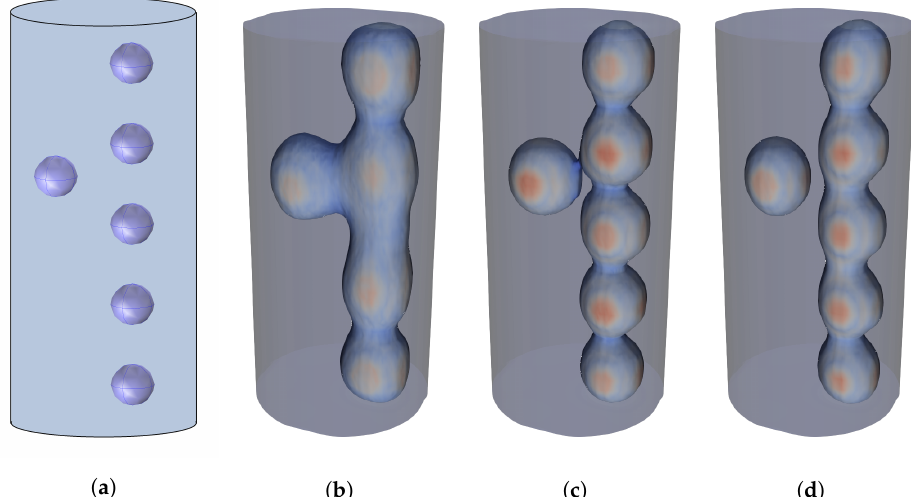
Figure 10. Figure shows the effects of cross-plane optimization in ECVT image reconstruction. ( a ) Flow model used in the simulation. ( b ) Reconstructed flow model obtained using 3D-ECT (no cross-plane measurement). ( c ) Reconstructed flow model obtained using optimal ECVT cross- plane measurements (measurements separated by more than three sensor layers are